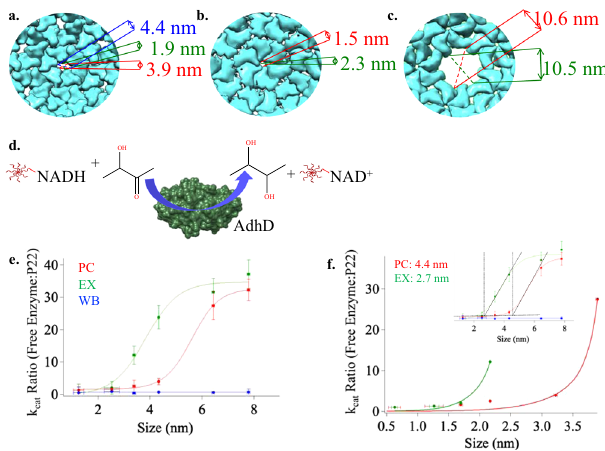
Fig. 3 Pore sizes based on available CRYO-EM data and measured effective pores sizes of P22. a – c Estimated pore dimensions of procapsid (PC) ( a ), expanded (EX) ( b ), and wif fl e-ball (WB) ( c ) using Chimera software program. d Reduction of acetoin using NADH conjugate as a cofactor and AdhD as a catalyst. e Plot showing k cat ratio using enzymes AdhD-SP (free) to encapsulated in PC (red), EX (green), and WB (blue) . f Aqueous pore model fi t of k cat ratio data and estimated pore sizes for PC and EX; inset: sigmoidal fi t and estimated pore sizes of 4.4 and 2.7 nm for PC and EX, respectively. Horizontal errors bars ( n = 3) are the standard deviation values for the hydrodynamic radii. Vertical errors bars ( n = 3) re fl ect the standard deviation for the turnover values ( k cat pore excluding the side chains (Fig. 4a). Without the side chains, HOLE shows a diameter of 4.4 nm, which is very close to the pore sizes calculated using Chimera. These results further underlined